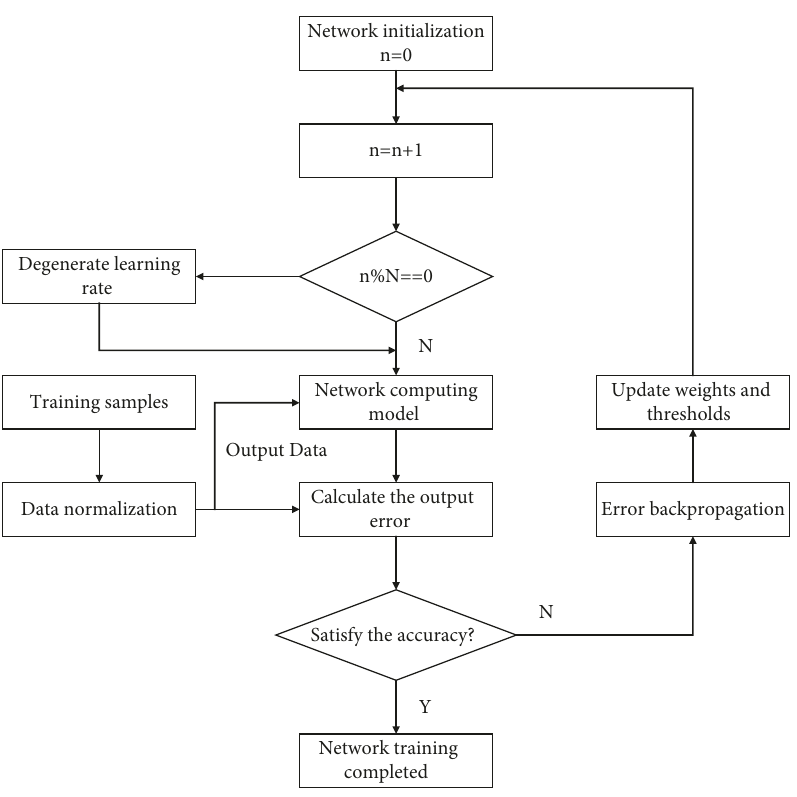
Figure 3: Training flowchart of the Elman neural